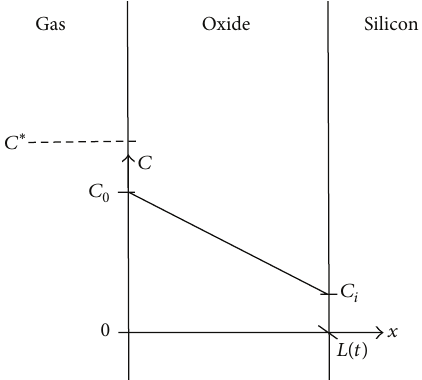
Figure 1: Model of Deal and Grove for the oxidation of silicon (after [5, Figure 3